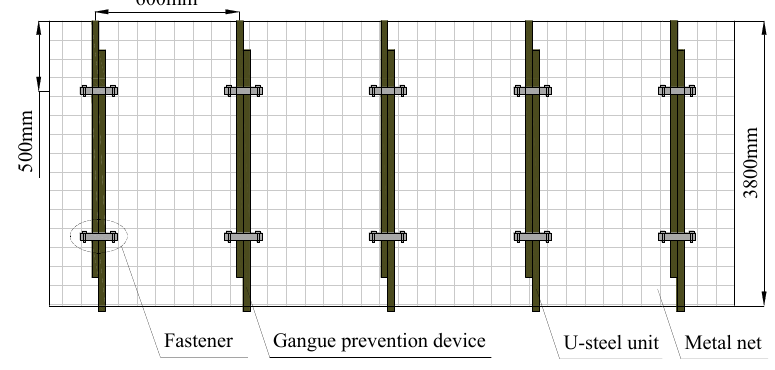
Figure 14. Entry-side support design.